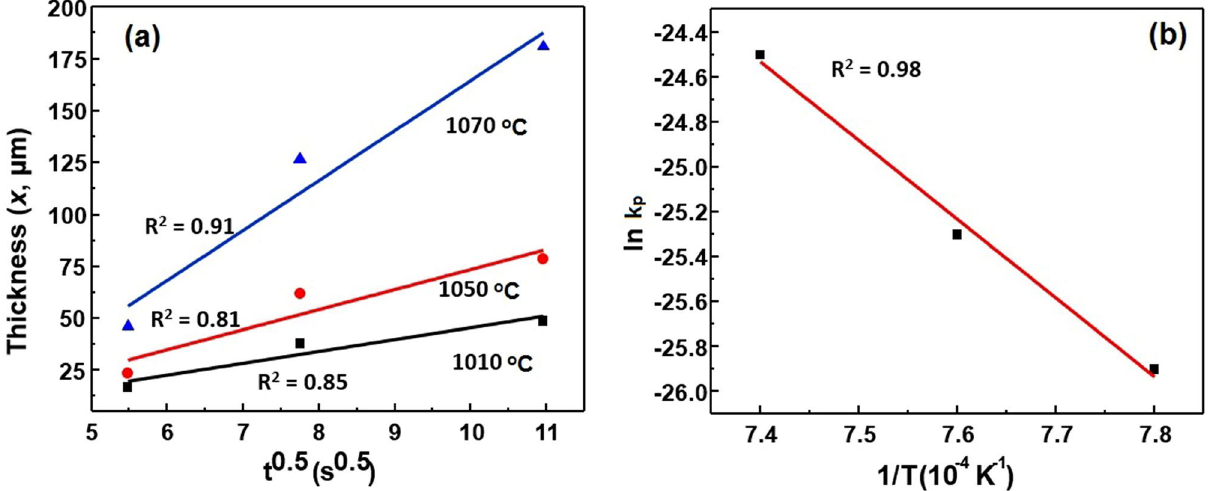
Figure 7. ( a ) The thickness of high entropy interfacial layer at various brazing conditions, and ( b ) Arrhenius plot of lnk p vs